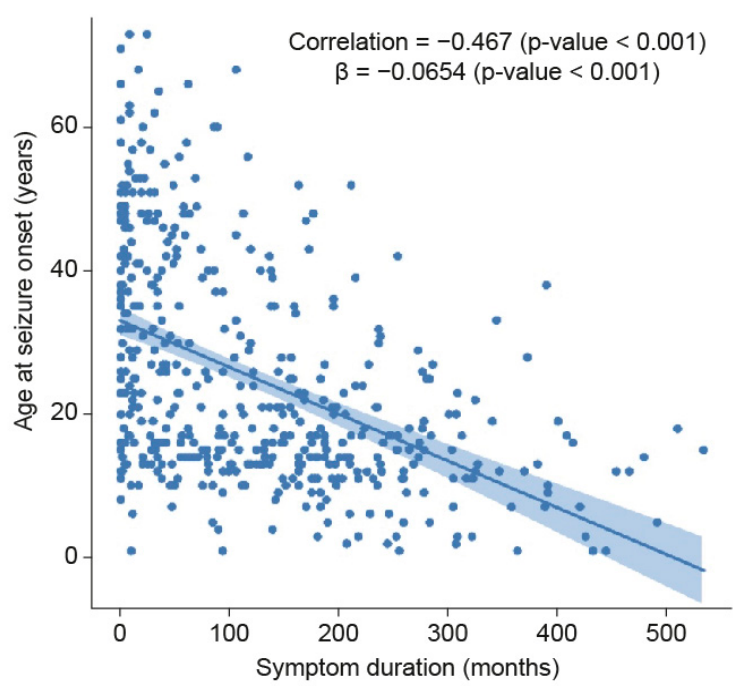
Figure 2. A relationship between age at onset of epilepsy and symptom duration. A statistically significant relationship was noted between age at onset of epilepsy and symptom duration in all subjects.